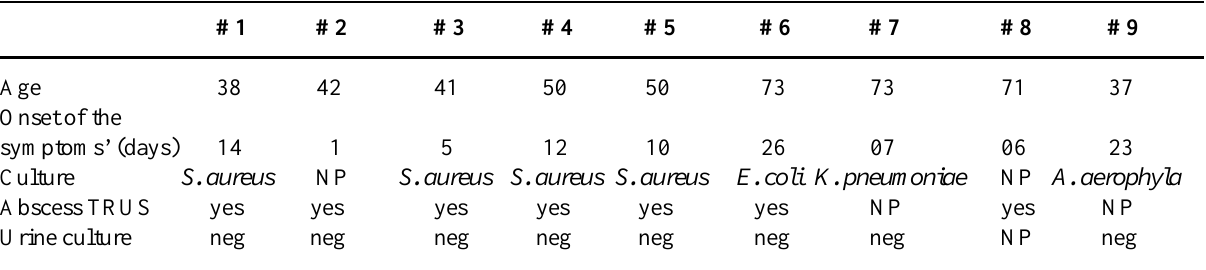
Table 2 – Demographic data and findings at the examination of patients with prostatic